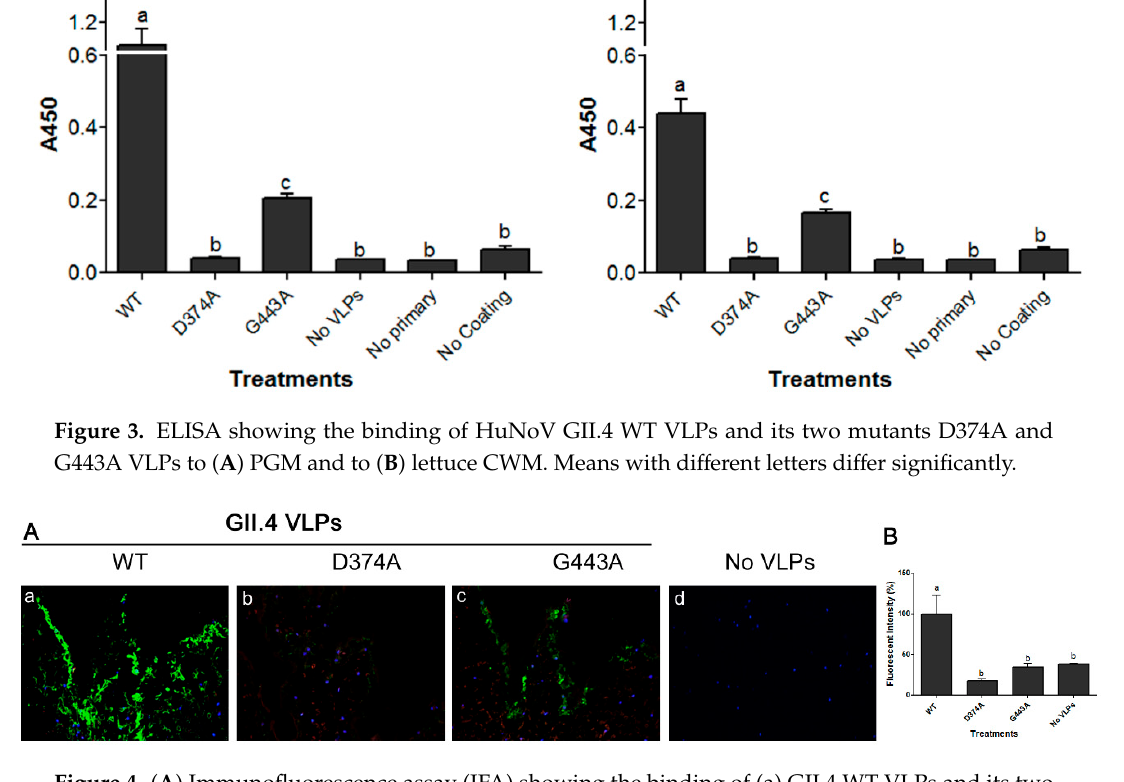
Figure 4. ( A ) Immunofluorescence assay (IFA) showing the binding of (a) GII.4 WT VLPs and its two mutants (b) D374A and (c) G443A VLPs to lettuce tissues as well as (d) control negative with no VLP added, Magnification: 40 × . ( B ) Quantification of fluorescent intensity. Means with di ff erent letters di ff er significantly.